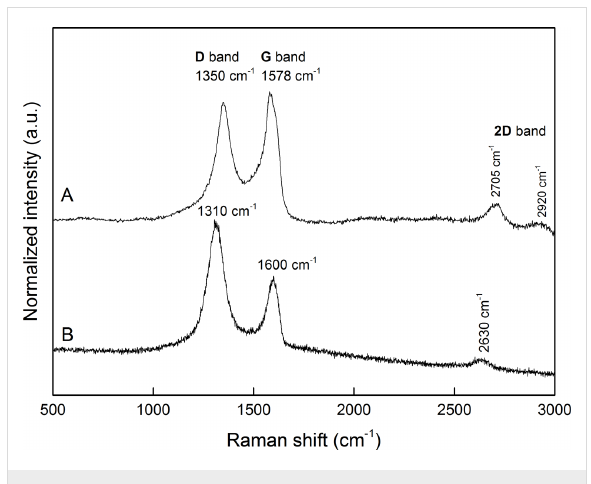
Figure 5: Raman spectra of A) GO and B)